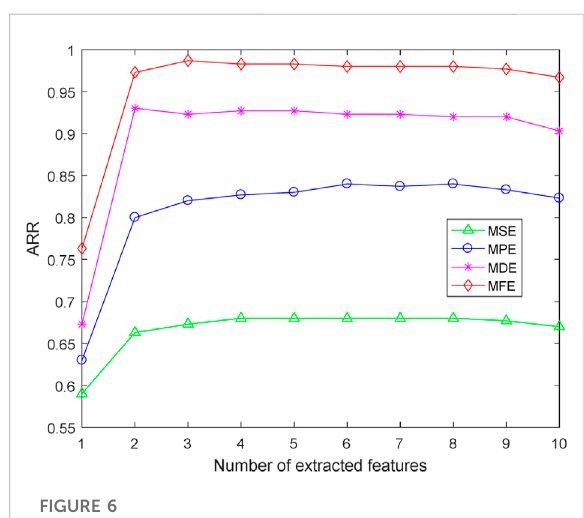
FIGURE 6 Highest ARR of four types of entropies for six